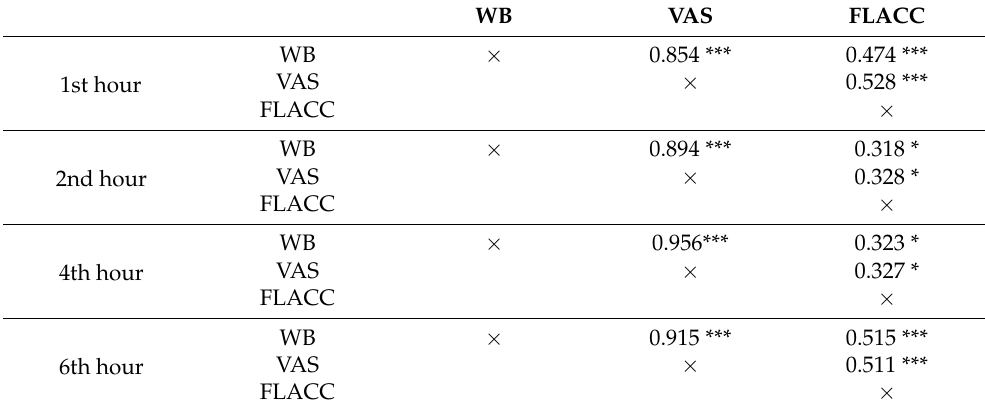
Table 4. Rank correlation coefficients (Spearman’s Rho) between pain